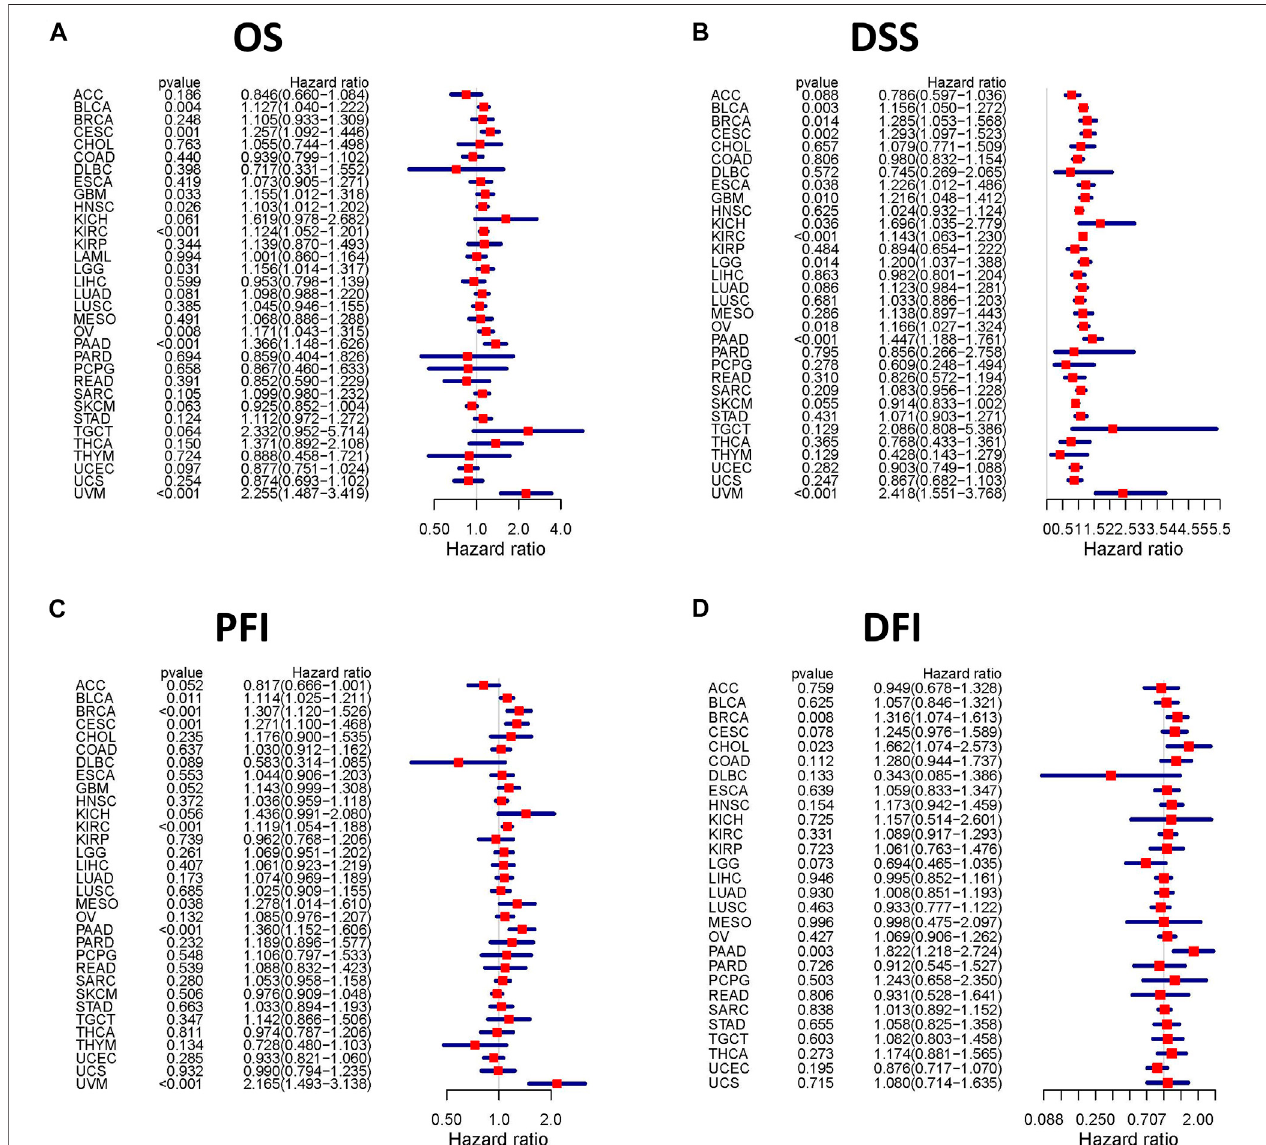
FIGURE 4 | Correlation analysis of TGFBI expression and patient survival by the Cox regression analysis in different cancer types. HR < 1 represents low risk and HR > 1 represents high risk. Univariate Cox proportional hazard regression models were applied for the association tests.